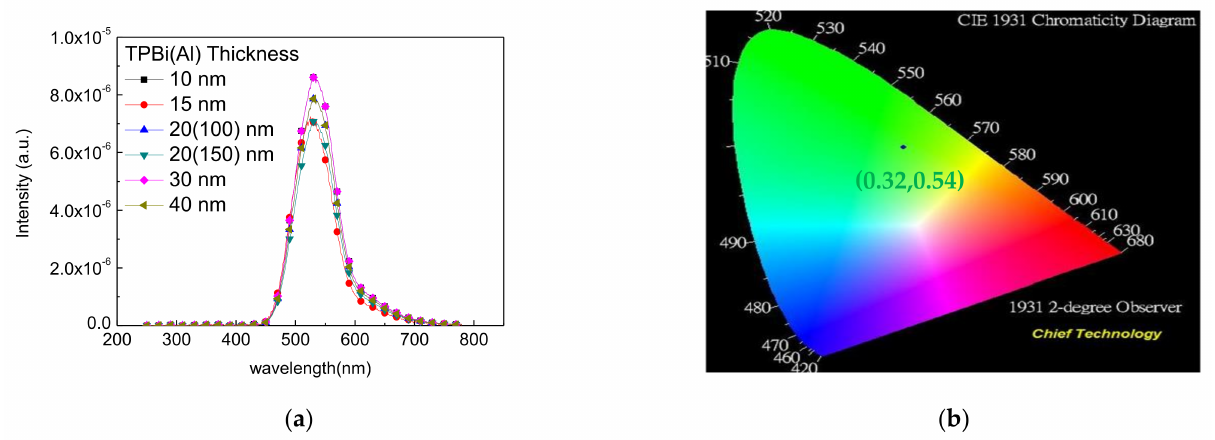
Figure 3. ( a ) The electroluminescence spectra under different TPBi film thicknesses, ( b ) CIE